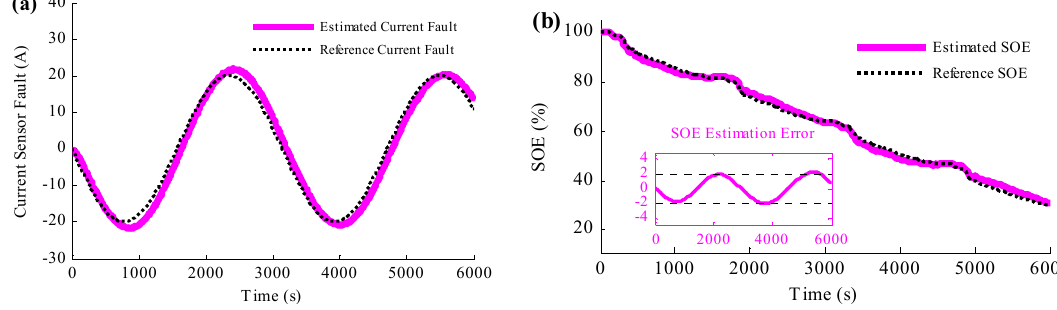
Figure 8. Simulation results when the current sensor fault is sinusoidal and the method to simultaneously detect the current sensor fault and estimate the SOE is applied: ( a ) the estimated current fault results; ( b ) the SOE estimation results.